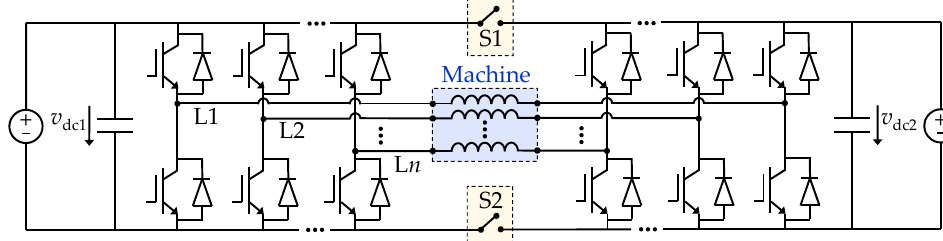
Figure 11. Open-end winding topology with bidirectional switches (S1 and S2) to alternate between dual n -phase HB VSC and single n -phase FB